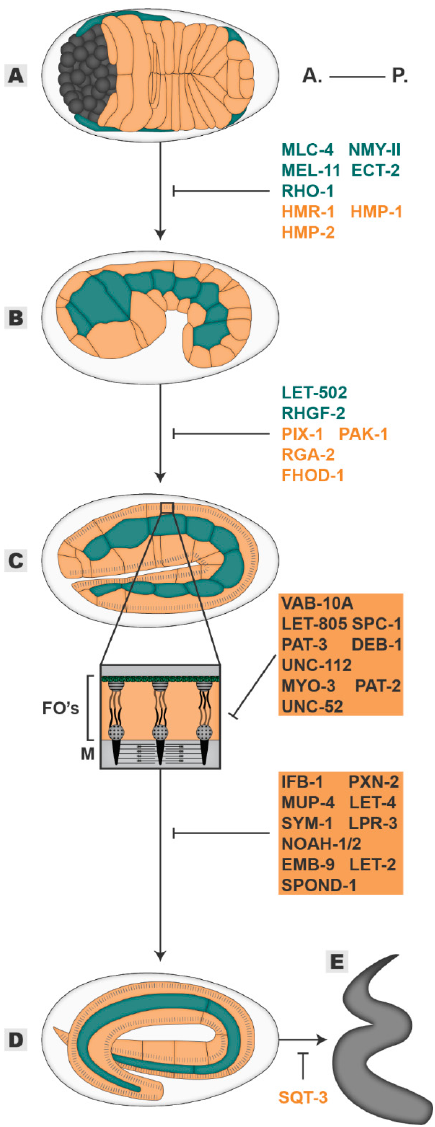
Figure 3. Elongation. The embryo progressively elongates from an initial 50 µm oval shape ( A ), through 1,5-fold ( B ), two-fold ( C ) and three-fold stages ( D ) until it hatches as a larva ( E ). Players in blue are required mainly in the seam cells, players in orange are required mainly in the dorsal / ventral cells, players in grey highlighted in orange are required in muscle and epidermal tissues. All inhibitory signs are representative of the outcome of the absence of a player. Embryos oriented with anterior (A.) on the left and posterior (P.) on the right. FOs—Fibrous Organelles,